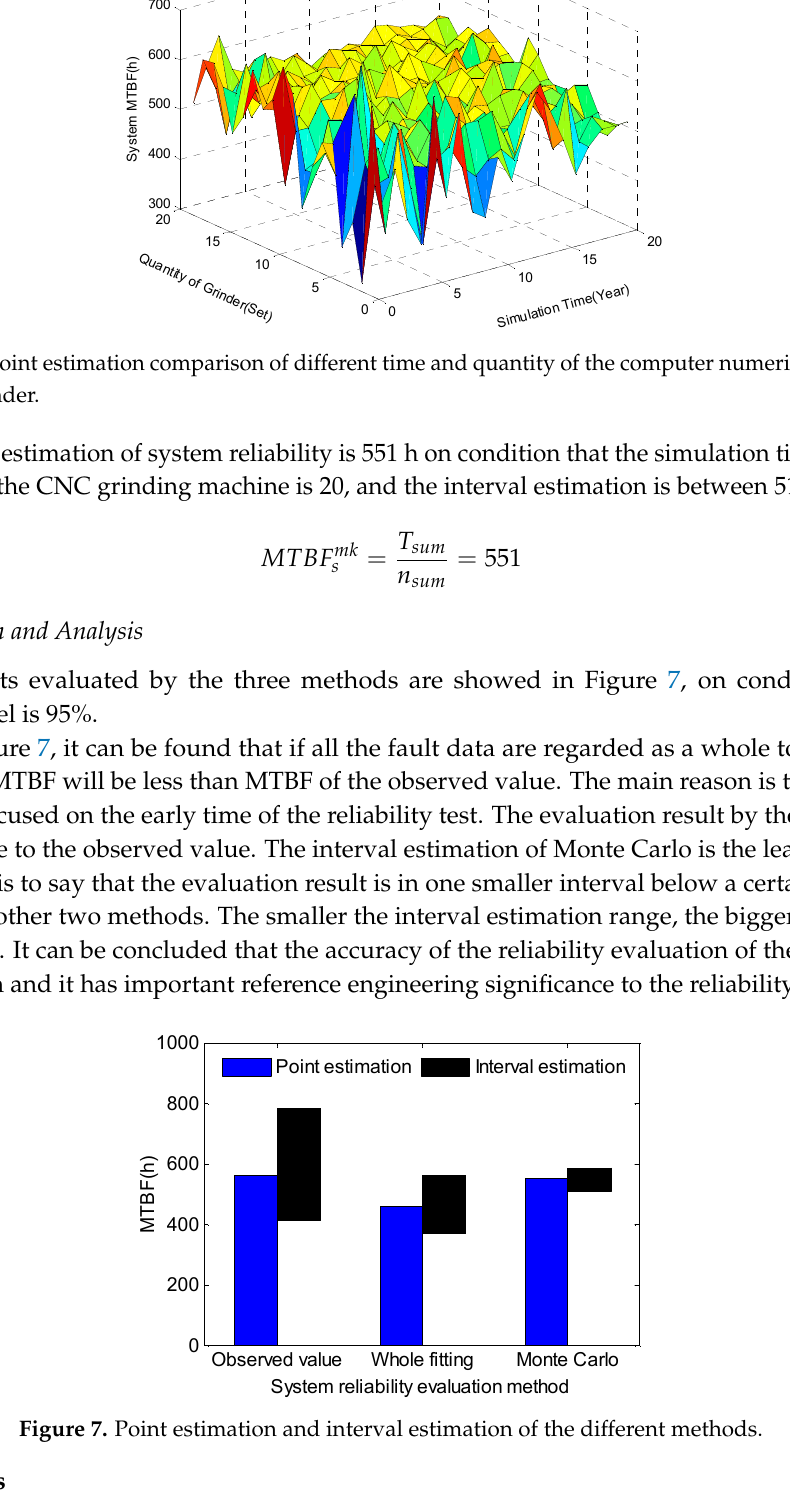
Figure7. Point estimation and interval estimation of the different methods.